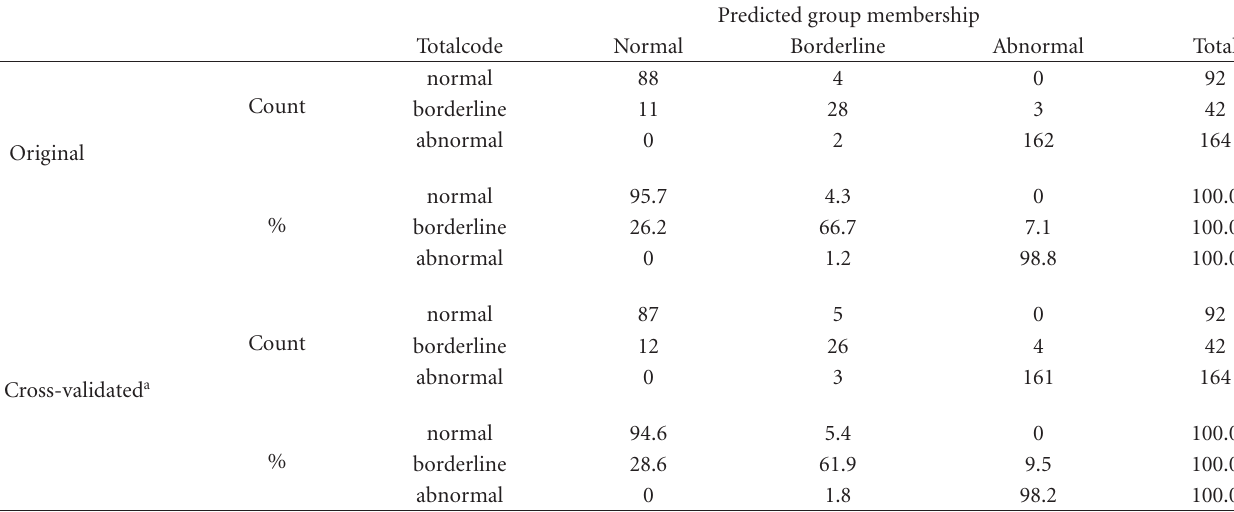
Table 10: Discriminant analysis classification results (93.3% of original grouped cases correctly classified; 91.9% of cross-validated grouped cases correctly classified).